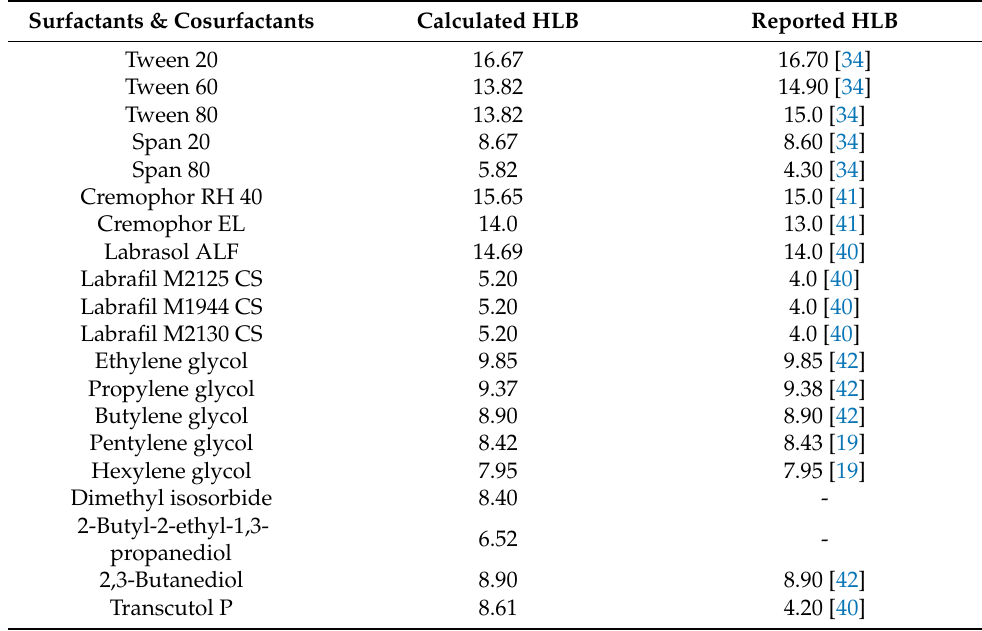
Table 3. Selected surfactants and cosurfactants with their calculated and reported HLB values. Surfactants & Cosurfactants